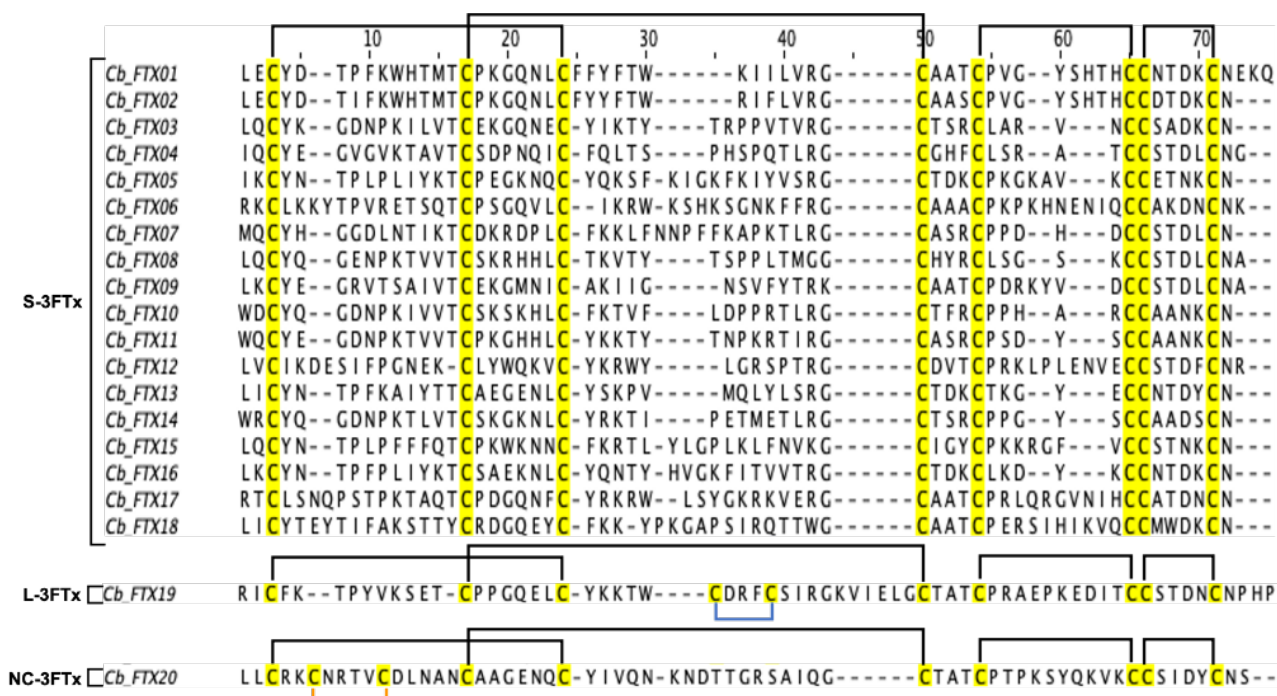
Figure 3. Multiple sequence alignments of three-finger toxin (3FTx) transcripts from Calliophis bivirgata flaviceps . Black brackets denote the four disulfide bridges in all 3FTx, while blue and orange brackets represent the fifth disulfide bridges present in L-3FTx (second loop) and NC-3FTx (first loop), respectively.